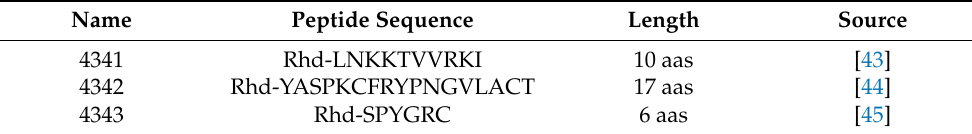
Table 2. Peptide sequence of the selected peptides, rhodaminated (Rhd). aas is the abbreviation for amino acid